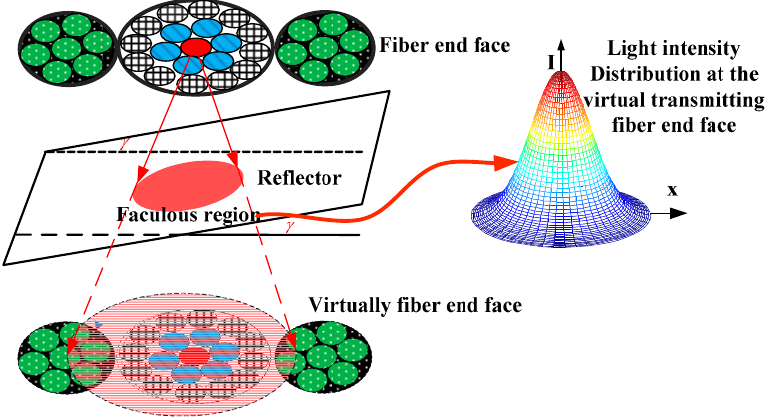
Figure 2. Geometry of the light intensity modulation mechanism.